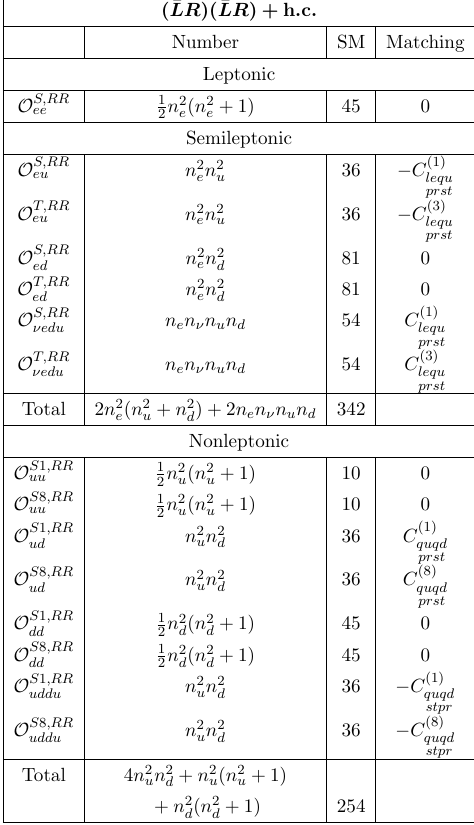
Table 17 . Dimension-six four-fermion operators: (¯ LR )(¯ LR ) scalar and tensor bilinears in LEFT. There are also Hermitian conjugate operators, as indicated in the table heading. The operators are divided into leptonic, semileptonic, and nonleptonic operators. The second column is the number of operators for an arbitrary number of neutrino flavors n ν , charged lepton flavors n e , u -type quark flavors n u , and d -type quark flavors n d , and the third column is the number in the SM LEFT with n ν = 3, n e = 3, n u = 2, and n d = 3. The last column is the tree-level matching coefficient in